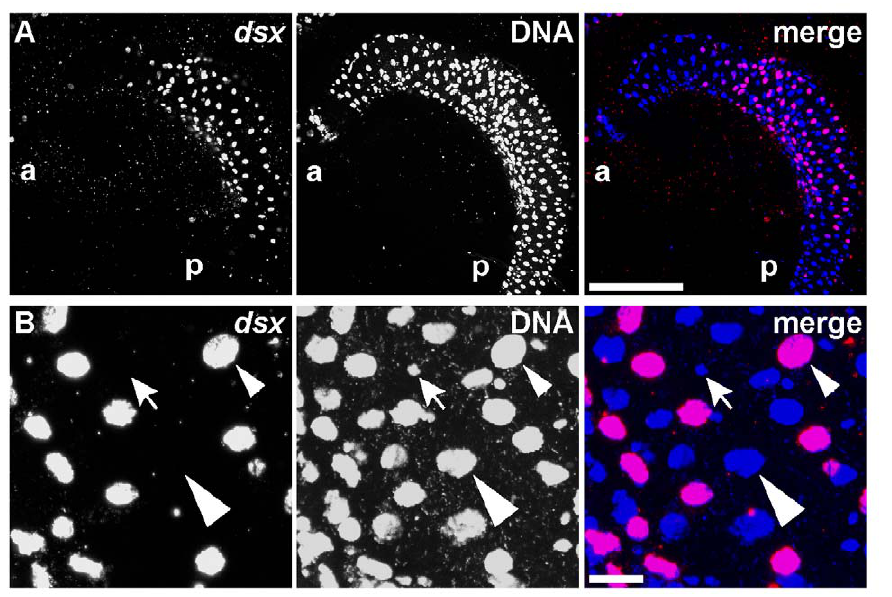
Figure 5. dsx GAL4 is expressed in a subset of cells of the midgut. (A) The frequency of cells expressing UAS-RedStinger nuclear DsRed reporter (magenta) varies along the length of the anterior midgut from an adult female. Non-expressing nuclei are marked with DAPI alone (blue). Anterior (a) and posterior (p). Speckles of autofluorescent debris are seen in the area outside of the gut. Scale bar, 100 m m. (B) Magnified view of a region in (A). Some enterocytes express dsx GAL4 (small arrowhead) while others do not (large arrowhead). In this region of the gut, cells with smaller nuclei (barbed arrow) that are likely to be enterocrine or intestinal stem cells do not express dsx GAL4 . Scale bar, 10 m m.